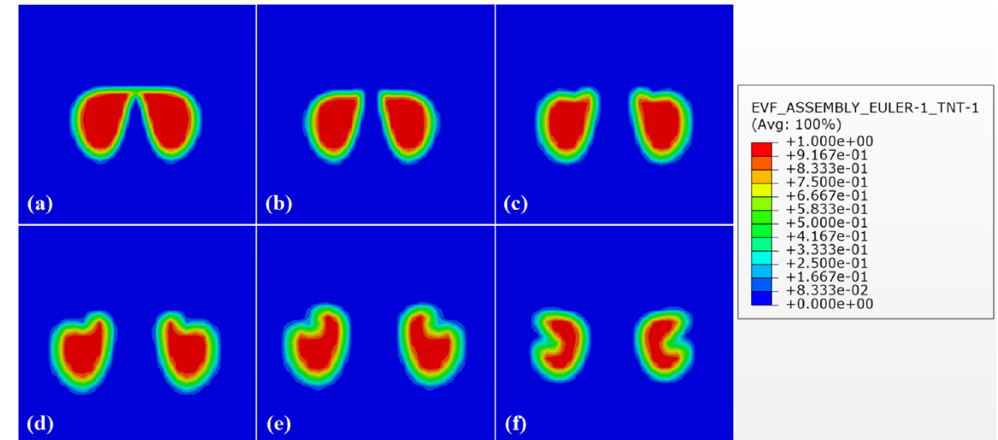
Figure 20. Simulated bubble motion during the collapse phase at: ( a ) t = 6.55 ms; ( b ) t = 6.60 ms; ( c ) t = 6.70 ms; ( d ) t = 6.75 ms; ( e ) t = 6.80 ms; and ( f ) t = 6.90 ms.